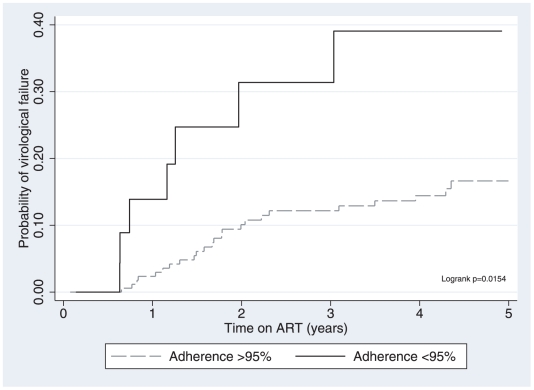
Cumulative hazard estimate for virological failure.